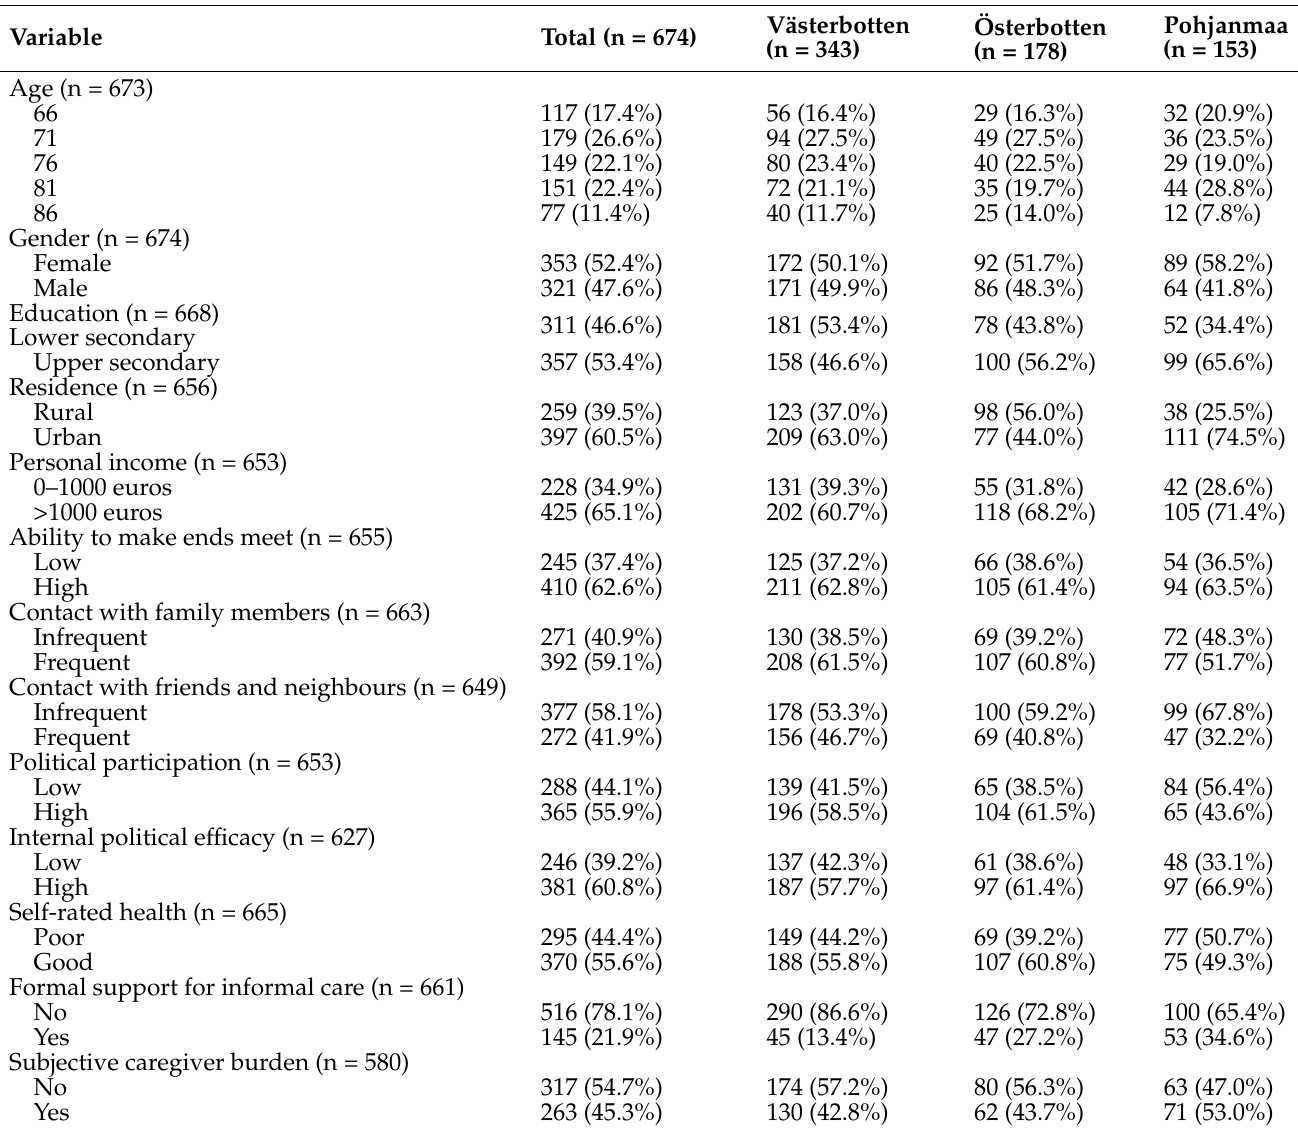
Table 1. Distribution of variables among older spousal caregivers in Västerbotten (Sweden),